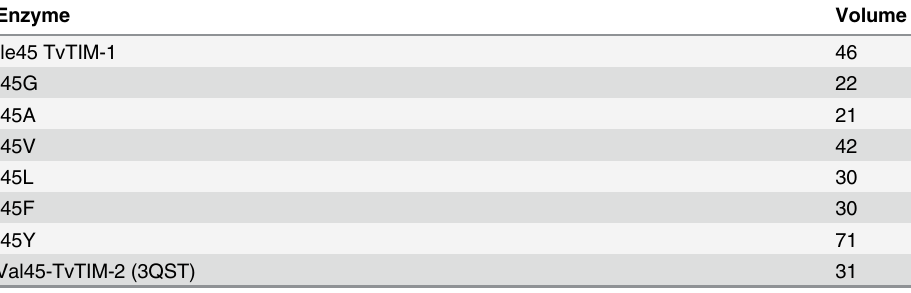
Table 3. Cavities at the ball and socket interaction by mutations of residue